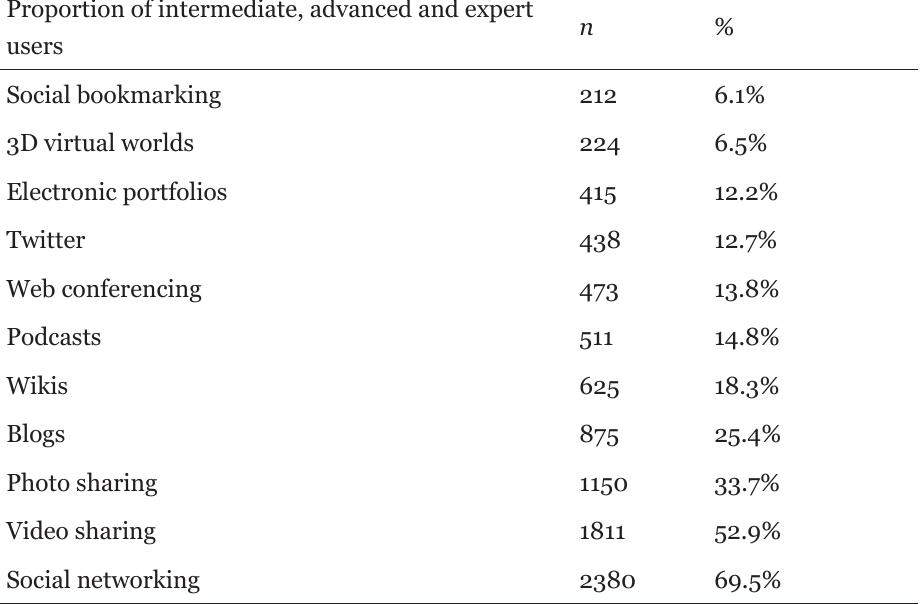
Social Software Proficiency Proportion of intermediate, advanced and expert